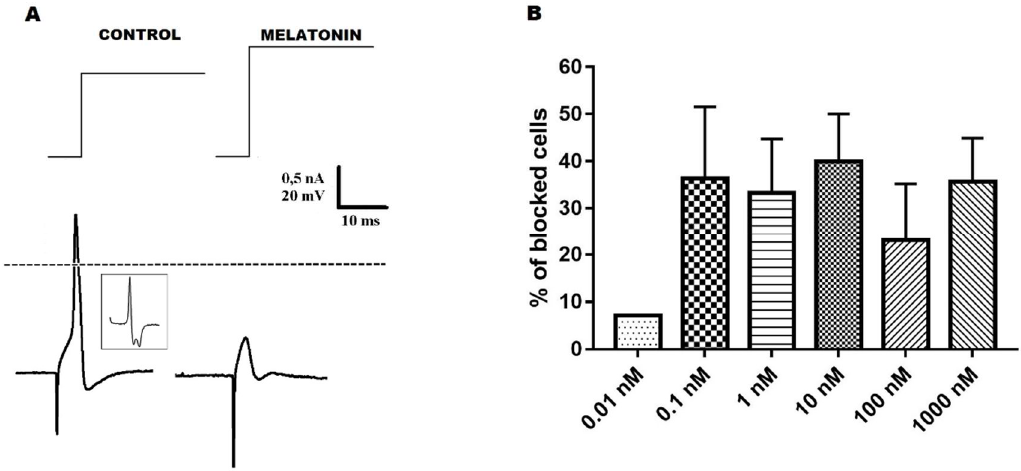
Figure 1. Melatonin-induced AP blockade in N inf neurons. Panel A shows representative traces illustrating melatonin effect on the AP of N inf neurons. Traces represent: upper row–current pulses; lower row–left, control AP; right–exposure to melatonin (1000.0 nM). Insert–d V / d t of control AP. Broken line is zero voltage reference. Panel B shows the percentage of neurons with AP triggering blocked (ordinate) by melatonin 0.01, 0.1, 1.0, 10.0, 100.0, and 1000.0 nM (abscissa). These data, expressed in percentage values, are presented as means ± SEM.